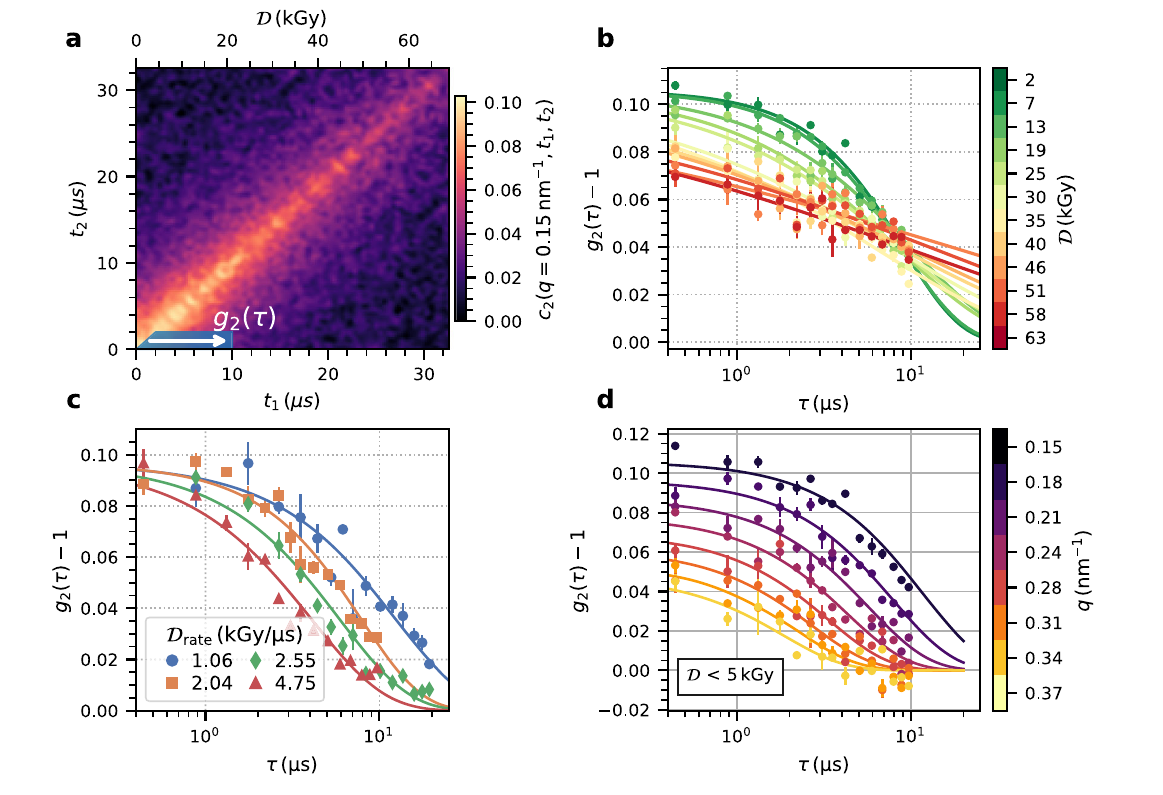
Fig. 3 | Correlation functions. a Two-time correlation function, c 2 , of Ig-PEG measuredwithanaveragedoserateof2.04kGy μ s − 1 for q =0.15nm − 1 . b Correlation functions for different initial doses ( D rate =2 : 04 kGy μ s − 1 , q =0.15nm − 1 ). c Correlation functions with an initial dose below 5kGy for different dose rates